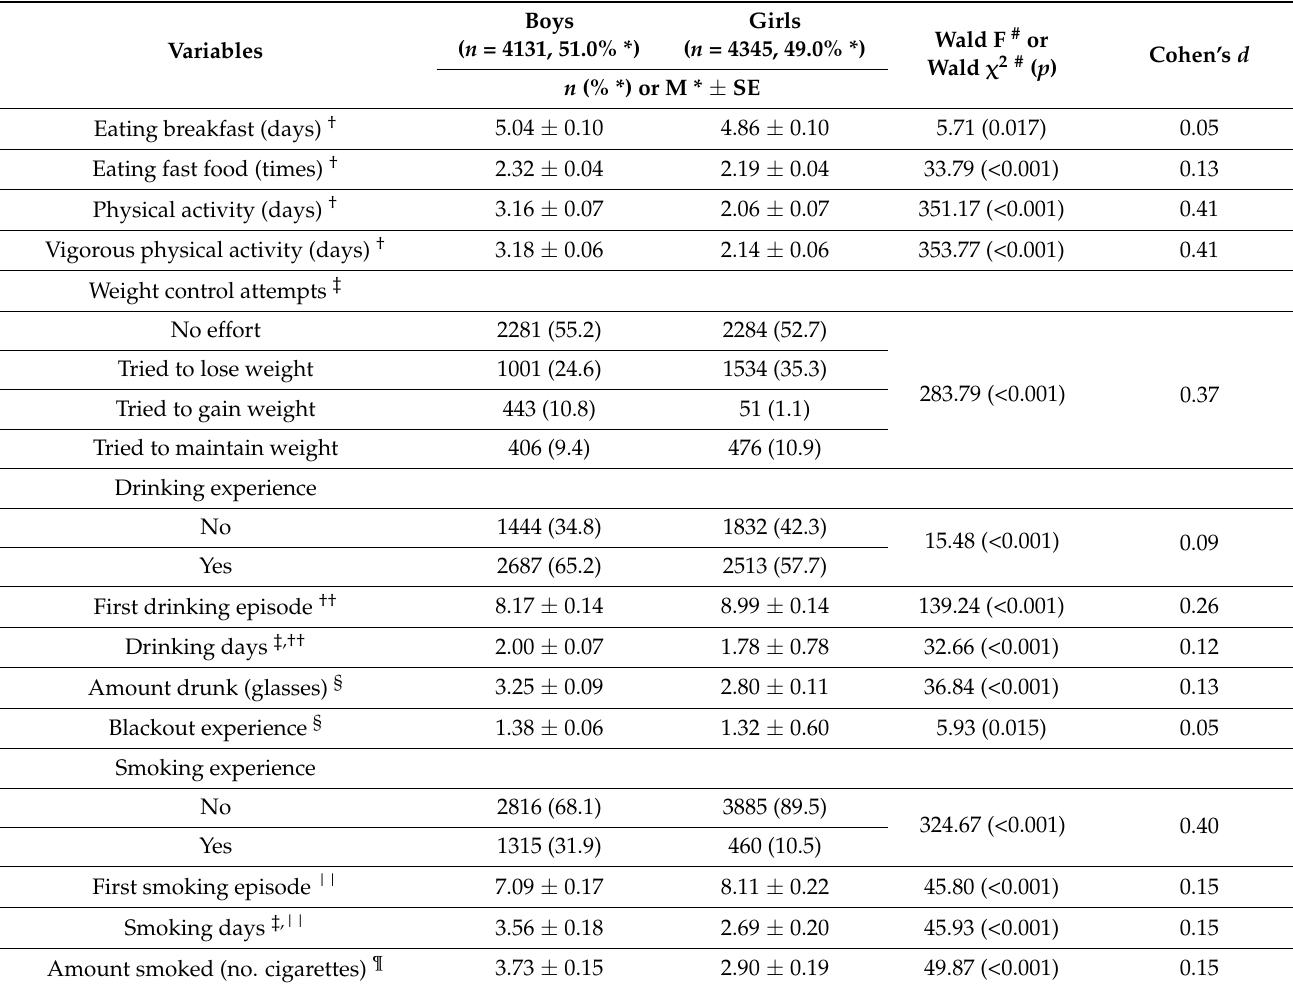
Table 2. Differences in lifestyle behaviors according to gender ( n =